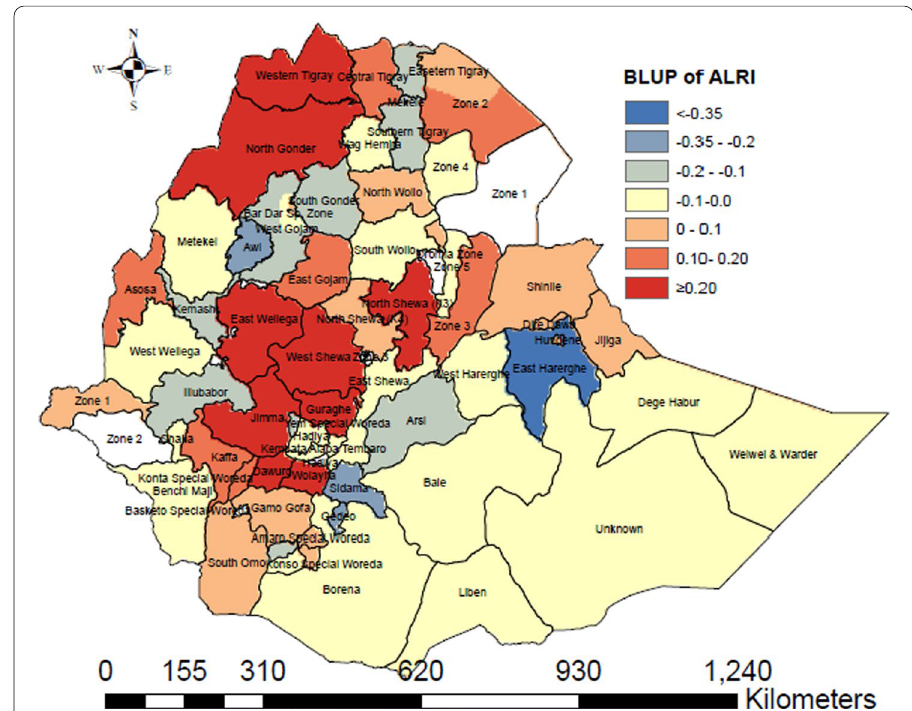
Fig. 4 The estimated BLUP of ALRI among under-five children among the Ethiopian administrative